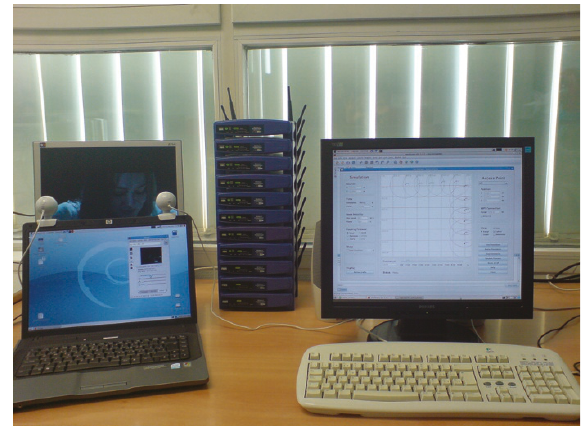
Figure 23: Testing a videocall when both webcams point to screen with a movie.